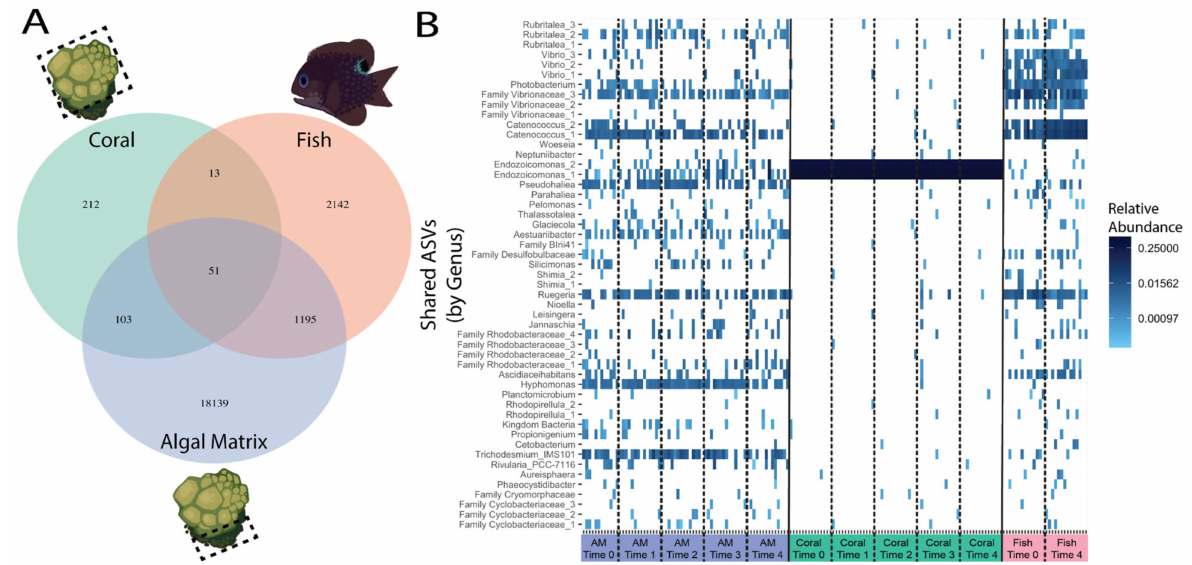
Figure 6. Unique and common ASVs across the three host microbiomes. ( A ) Venn-diagram of unique and shared ASVs between the 3 hosts shows that all hosts had 51 ASVs in common. ( B ) Relative abundance of these 51 ASVs for each host across time (‘AM’ = algal matrix). Darker colors indicate higher abundance, and no color indicates an absence of that